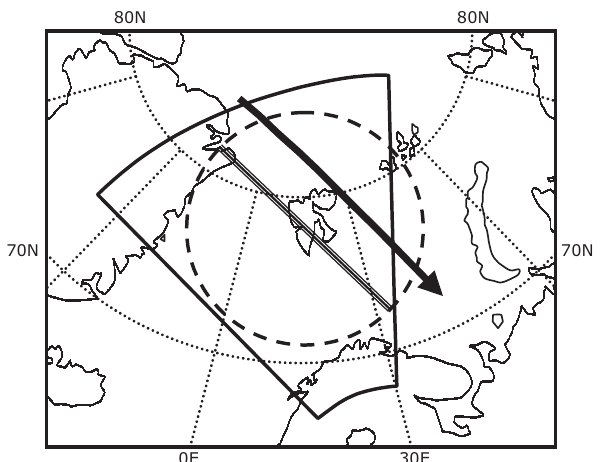
Fig. 1. Geographic coverage of the instrumentation used in this case study; the circular all-sky camera field-of-view, the fan- shaped CUTLASS Finland HF radar field-of-view, and the meridian scanned by the MSP. The FAST trajectory is also indicated with an